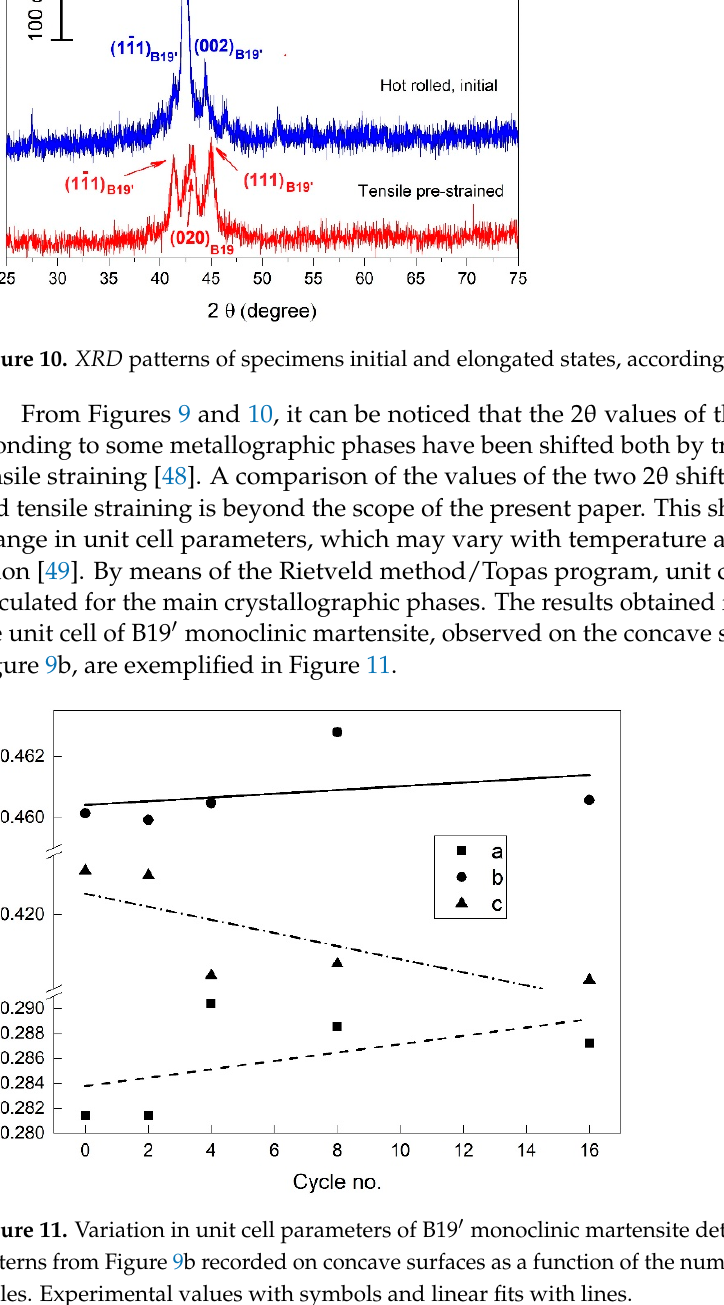
Table Table 4. Linear fit summary of the experimental values of unit cell parameters from Figure 11.